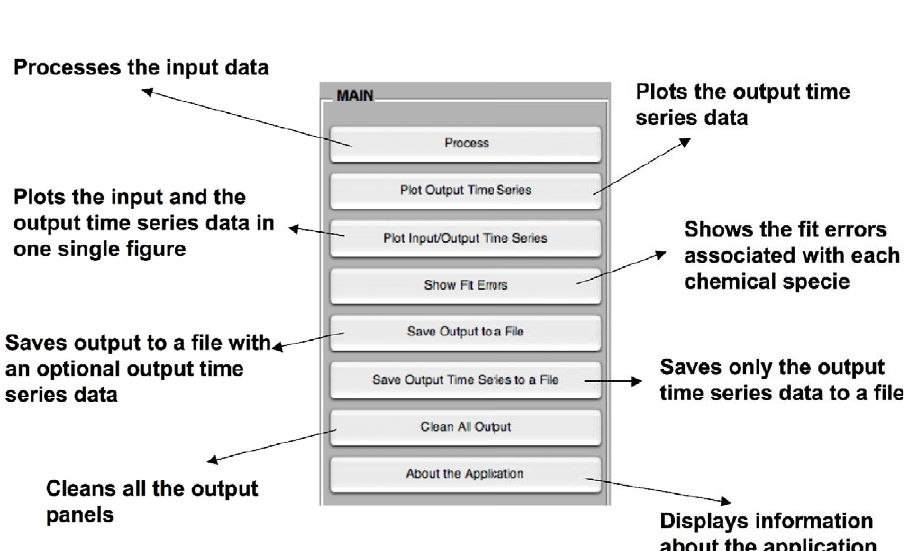
Figure 2. MIKANA’s GUI Main Panel functions. The Main panel (bottom right) of the GUI is composed of eight buttons. doi:10.1371/journal.pone.0027534.g002 PLoS ONE |